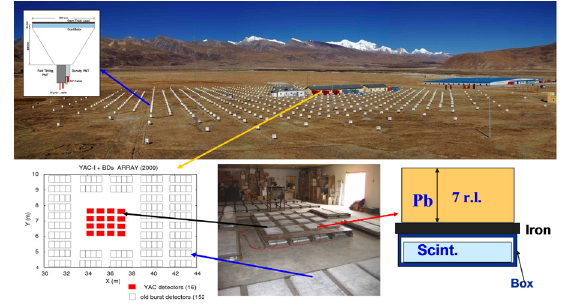
Figure 2. Schematic view of (YAC-I + Tibet-III) array. The Tibet- III consists of 789 detector units, the YAC-I consists of 16 detec- tor Figure 1. Energy spectra of primary cosmic-ray proton and helium nuclei obtained by Tibet-EC [4] compared with some other experimental results: ATIC2 [6], JACEE [7], RUNJOB [8], CREAM [9], KASCADE [5].